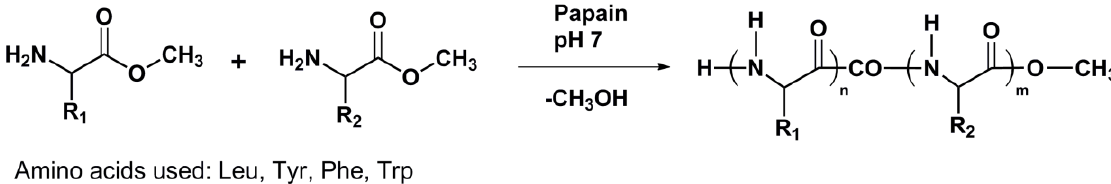
Figure 1. Reaction scheme of enzyme catalyzed amino acid (co)oligomerization R and R ≠ R 1 2